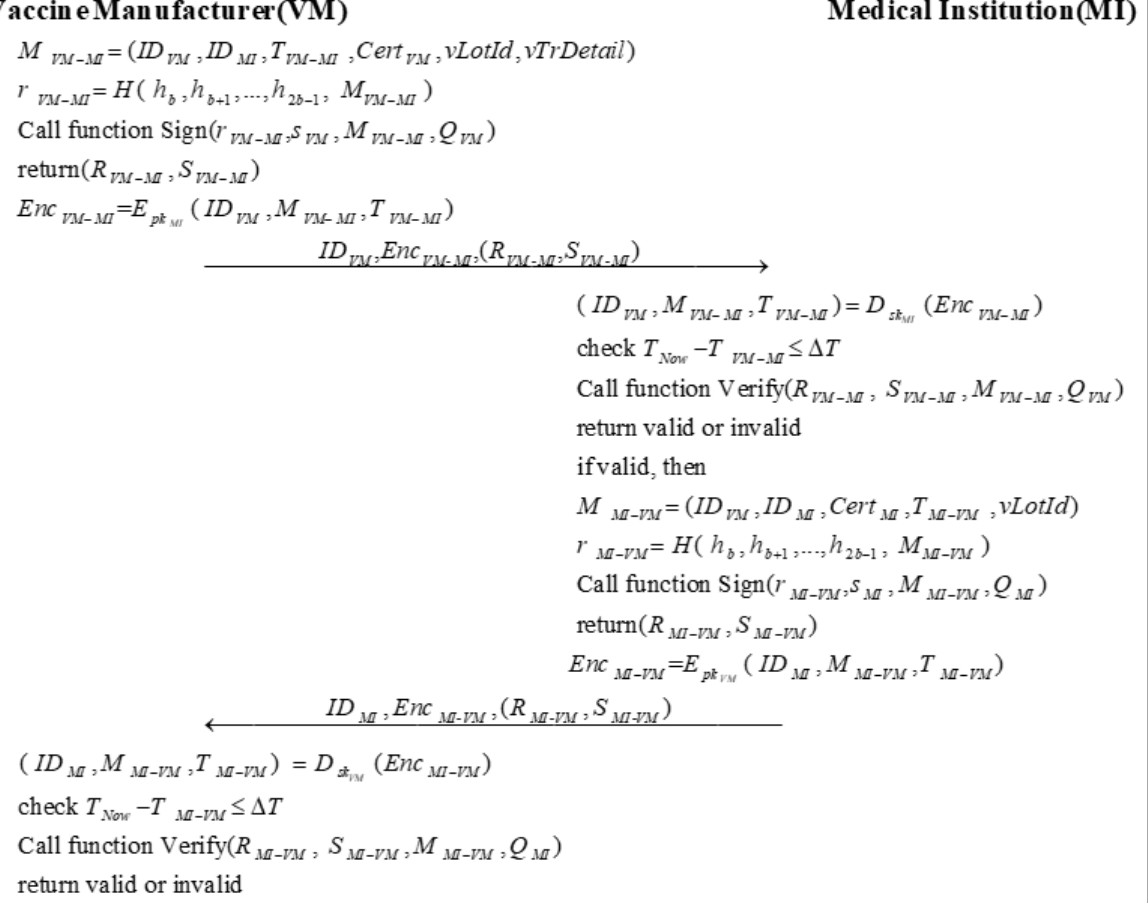
Figure 7. The process of vaccine transport.